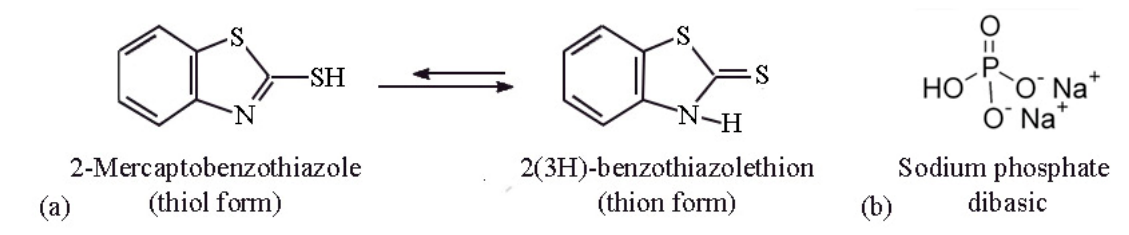
Figure 24. Schematic representation of ( a ) 2-mercaptobenzothiazole (thiol form) and 2(3H)- benzothaizolethion (thion form); ( b ) sodium phosphate dibasic [Na 2 HPO 4